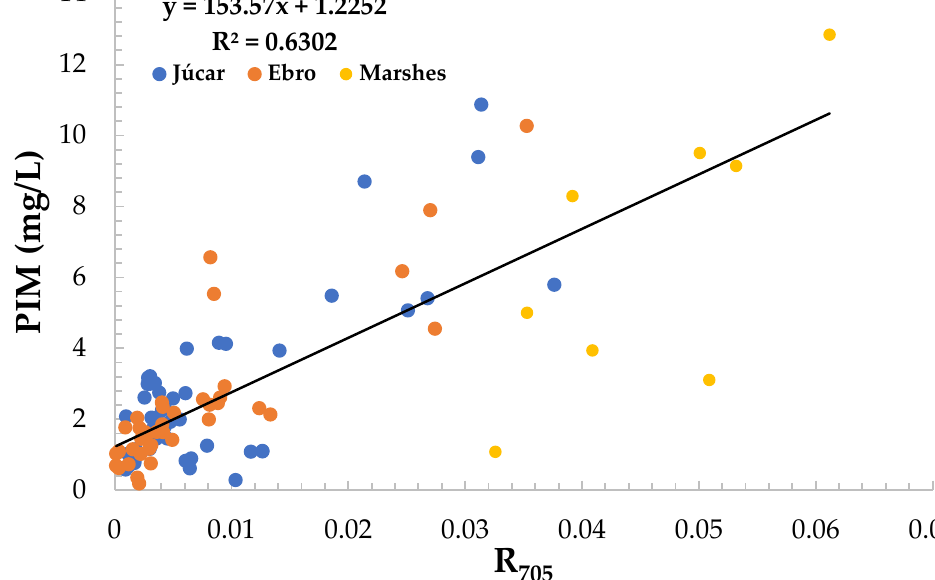
Figure 11. In situ PIM in function of R 705 using all data under 13 mg/L.